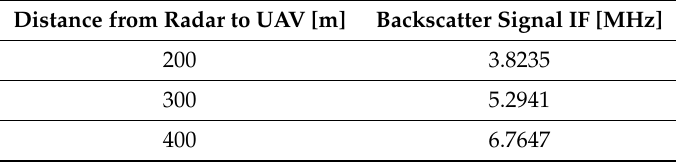
Table 1. Results of the distance calibration experiment.